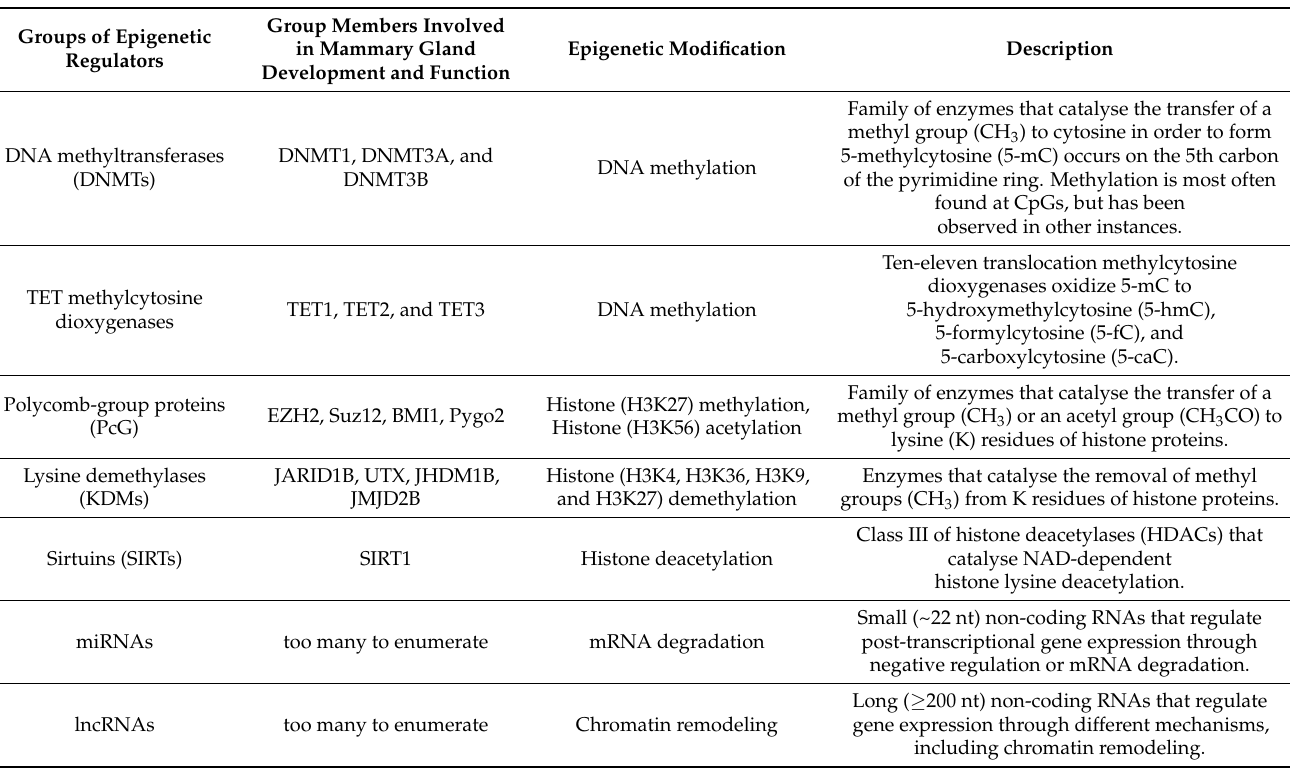
Table 1. Summary of epigenetic modifications and enzymes that play a role in mammary gland development and function. Groups of Epigenetic